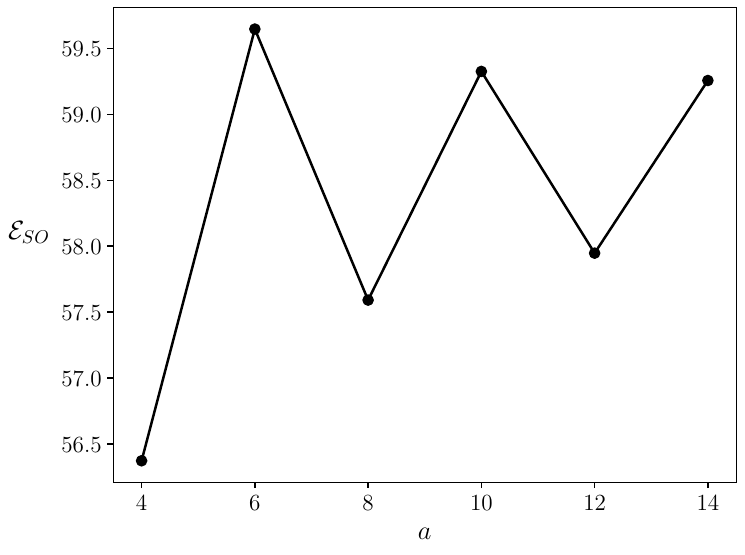
Figure 2: The Sombor energy of the unicyclic graph X a,b , a + b = 16 , plotted versus the size a of its cycle. The Sombor index is defined as [10]